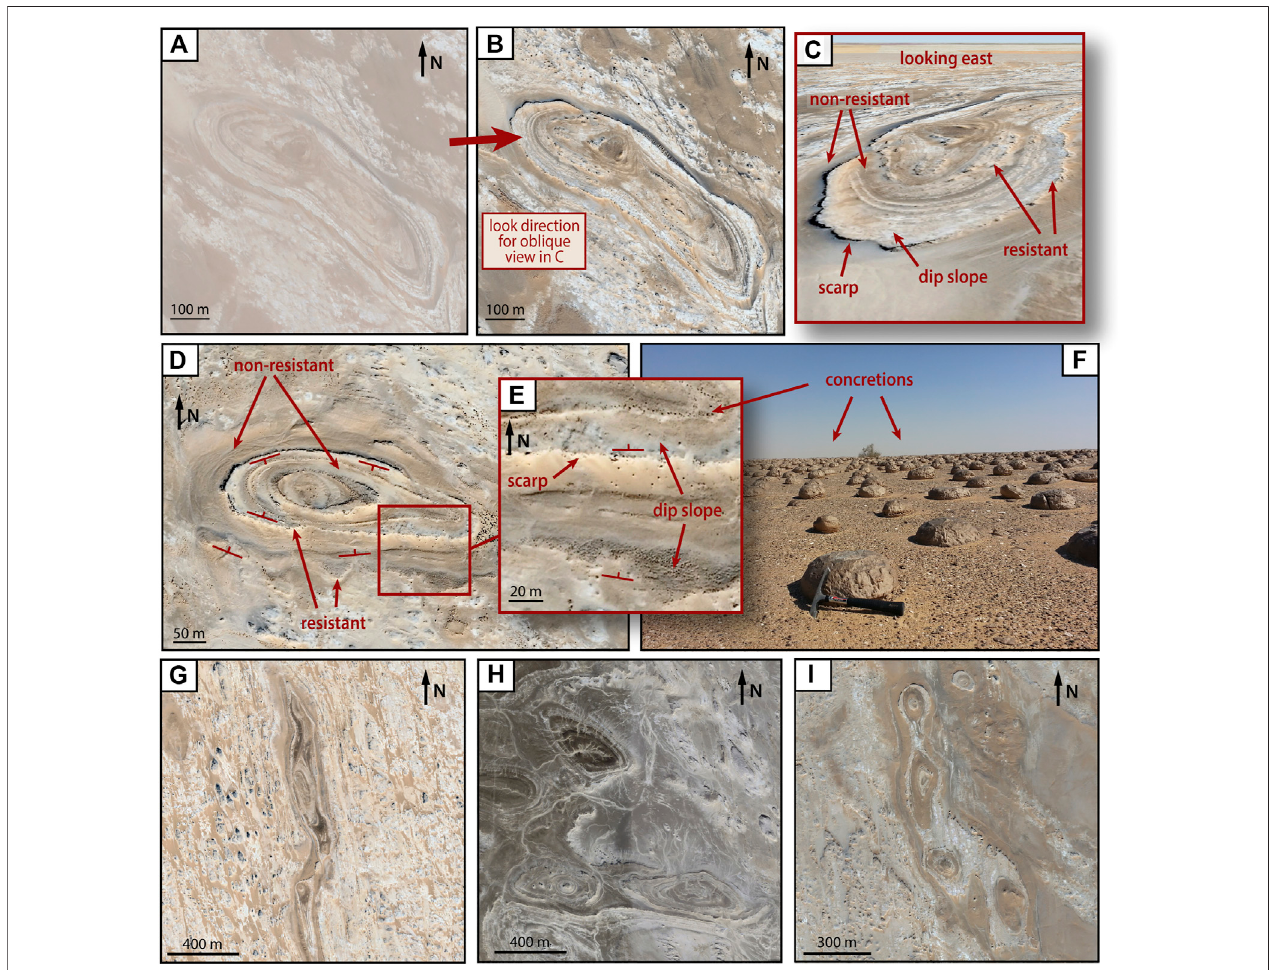
FIGURE 4 | Datasets and mapping methods. (A) Current high resolution ( < 1 m/pixel) Maxar image in Google Earth with low contrast and high sun angle, making structural mapping dif fi cult. (B) Equally high resolution Maxar image of same area as 4A, accessed using historical imagery slider; high contrast and low sun angle are ideal for structural mapping. (C) Oblique view looking ENE across syncline shown with red arrow in 4B; shows thin limestone interlayers with different resistance to erosion and appearance in satellite imagery, which make identi fi cation of synclines possible. ( D) Differences in erosional resistance between limestone layers less than a few meters thick produces low scarps and prominent dip slopes. We use relative locations of scarps and dip slopes, Vs in micro-wadis, and scallops in micro hogback ridges to determine dip direction. (E) Zoomed-in view of dip indicators. (F) Dark speckles in 4F are large concretions that are ubiquitous on weathered dip slopesofsiliceouslimestonelayers.Hammerforscaleinfrontofforegroundconcretion. (G – I) Ourmappingmakesuseofdistinctivepatternscharacteristicofsynclinesin the network as established in our previous mapping area (Tewksbury et al., 2017a), including narrow color stripes of dipping layers in syncline limbs and “ eyes ” with concentric color rings in basin closures. Satellite imagery source: Google Earth. Coordinates for Google Earth images: A – C) 26.232518, 30.991498; D) 26.249925, 30.958276; E) 26.249151, 30.959524; G) 26.257994, 30.833053; H) 26.889168, 31.164989; I) 26.275977, 30.801059.